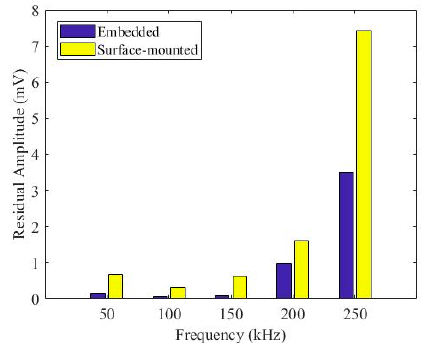
Figure 16. Residual amplitude comparison between embedded and surface ‐ mounted signals.